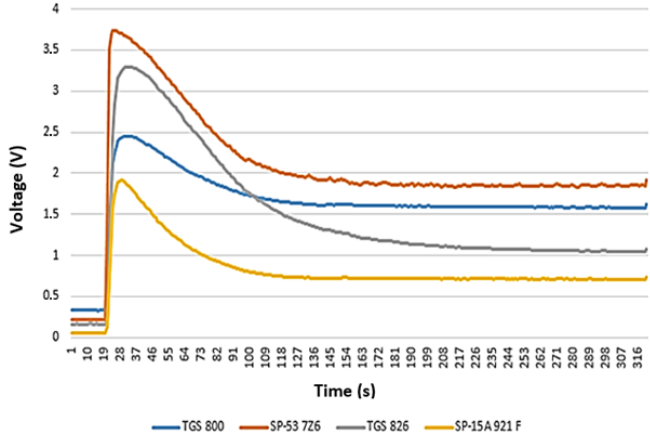
Figure 8. Response of the sensors without temperature modulation, exposed to a sample of alcohol